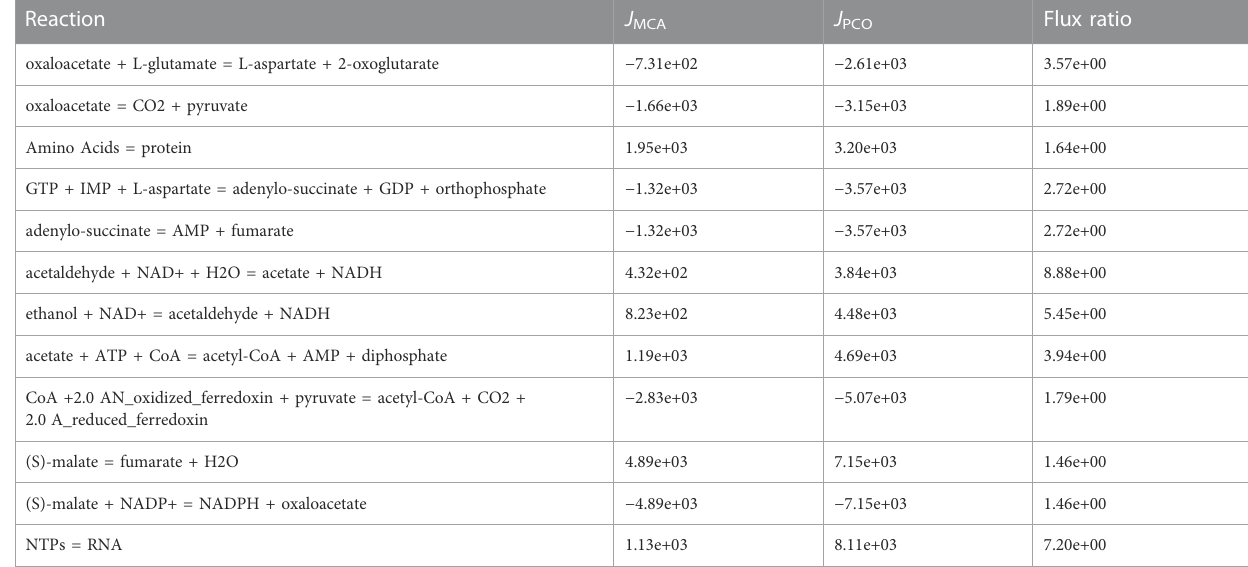
TABLE 3 Top 12 reactions from the constrained optimization that have the highest fl uxes. The reactionthat has the highest fl ux in the constrained optimization is thegrowthreactionforRNAsynthesis.Likewise,thereactionforproteinsynthesisisincludedinthisgroup.Otherreactionswiththehighest fl uxareallinvolvedin uptake and processing of the carbon source,